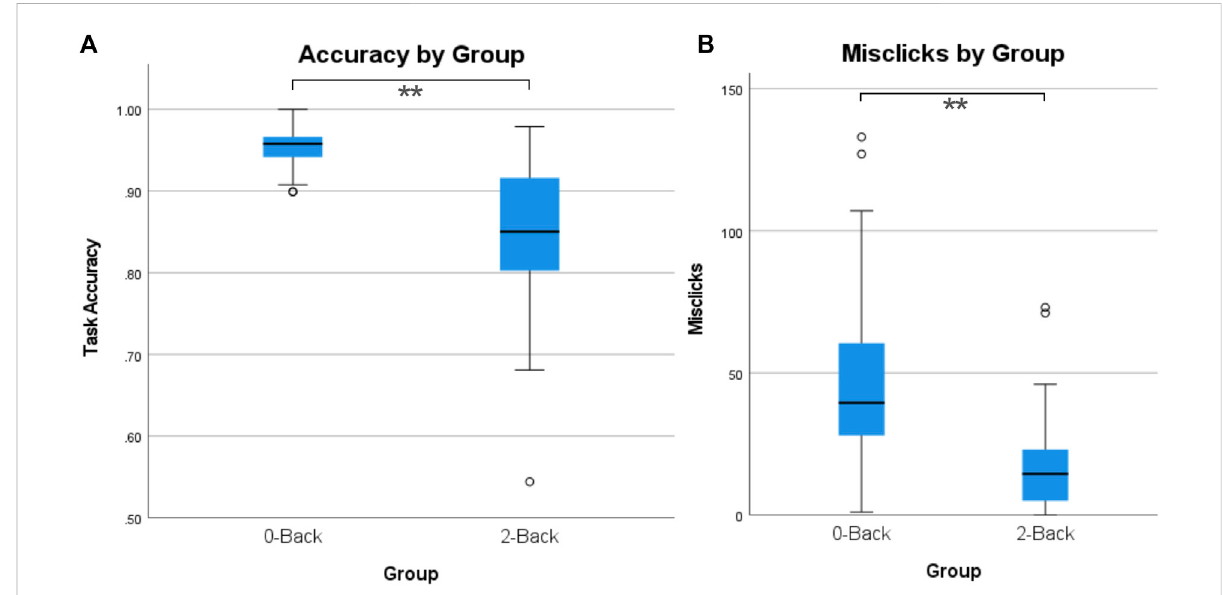
FIGURE 8 Maze task performance: (A) Accuracy by group; (B) misclicks by group.